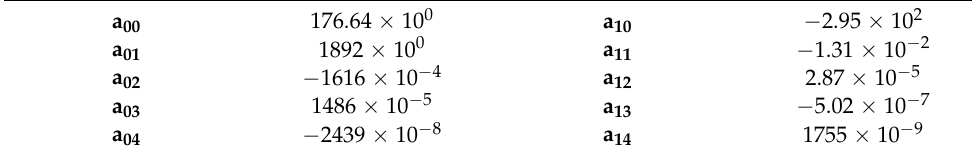
Table A35. Coefficients of the (CH 3 ) 2 CO-ZnBr 2 enthalpy